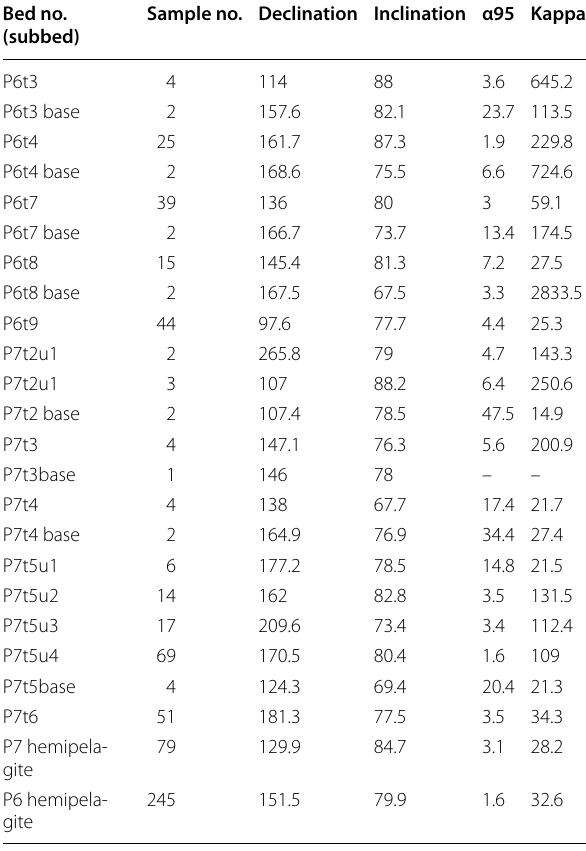
k Fisherian precision parameter, α95 radius of cone of 95% confidence